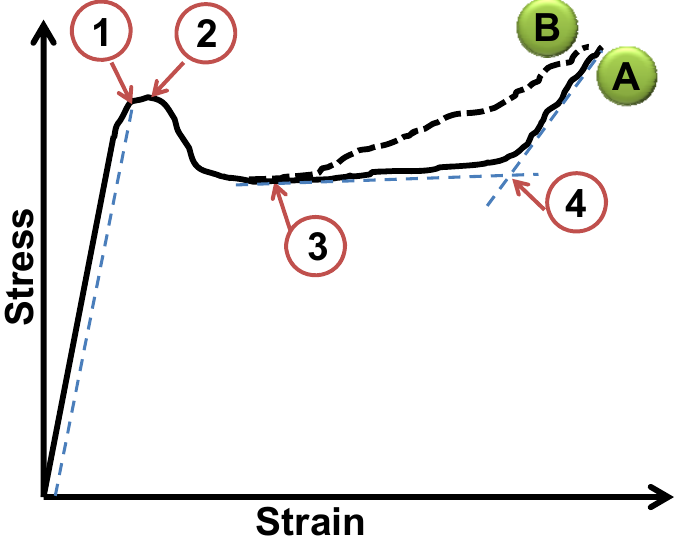
Figure 8. Schematic representation of a typical compressive stress-strain curve for